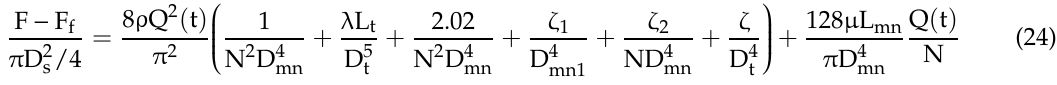
Table 2. Constants and variables used in Equation (24) [129].